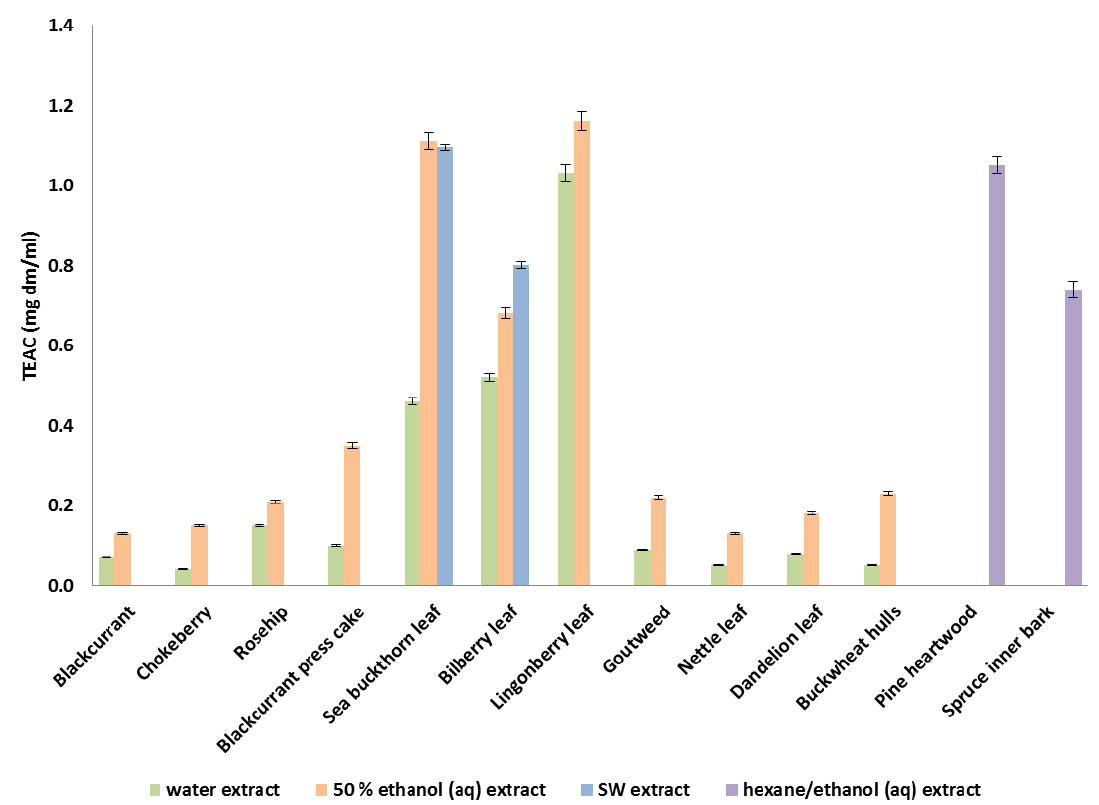
Figure 2. Radical scavenging activity as TEAC (mg dm / mL) of the selected plant extracts.